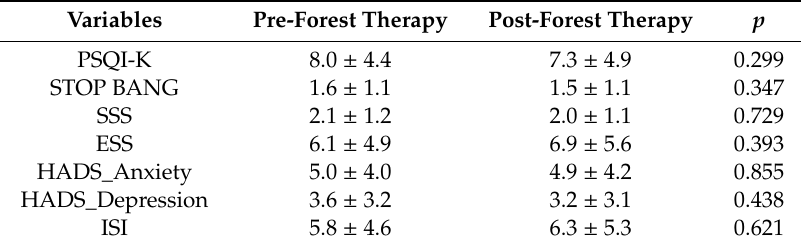
Table 3. Sleep questionnaire